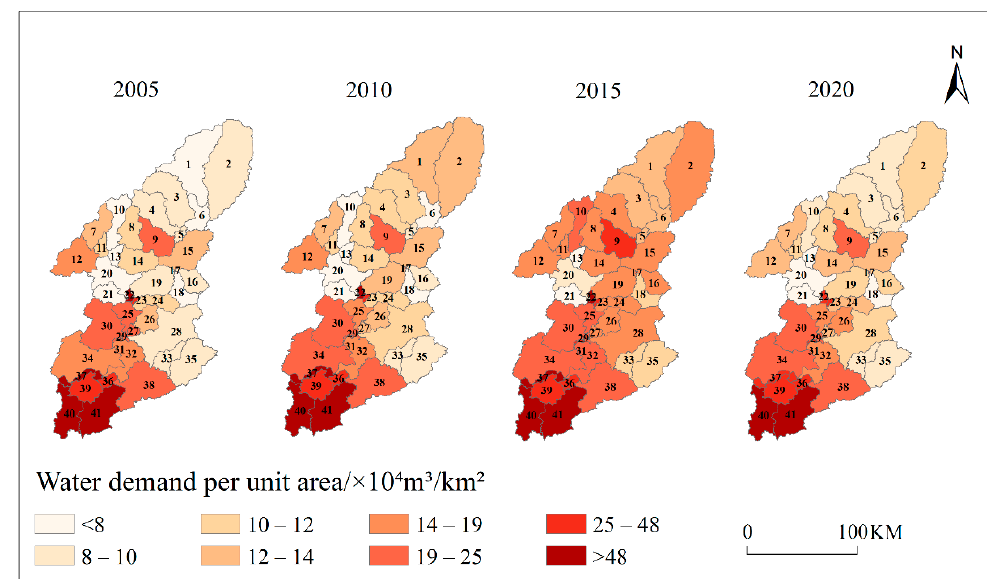
Figure 5. Spatial distribution of water demand per unit area in the Dongjiang River Basin from 2005 to 2020.